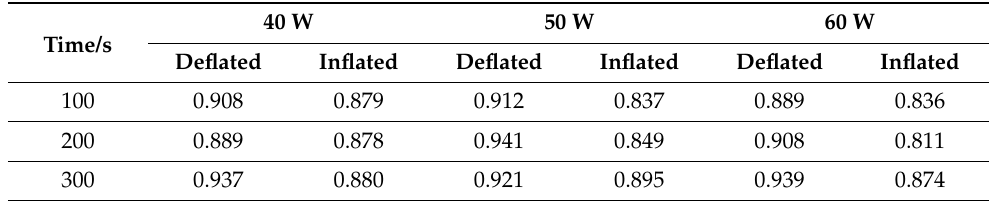
Table 8. Isoperimetric ratio of ablation area in each group. 40 W 50 W 60 W Time/s Deflated Inflated Deflated Inflated Deflated Inflated 100 0.908 0.879 0.912 0.837 0.889 0.836 200 0.889 0.878 0.941 0.849 0.908 0.811 300 0.937 0.880 0.921 0.895 0.939